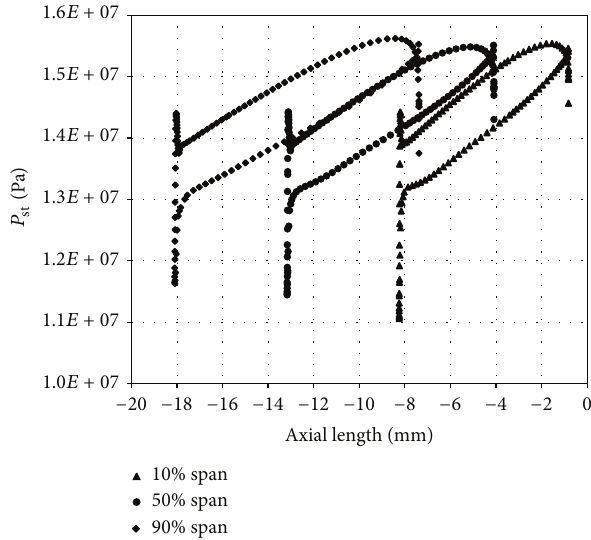
Figure 16: Blade loading distribution at different spans.